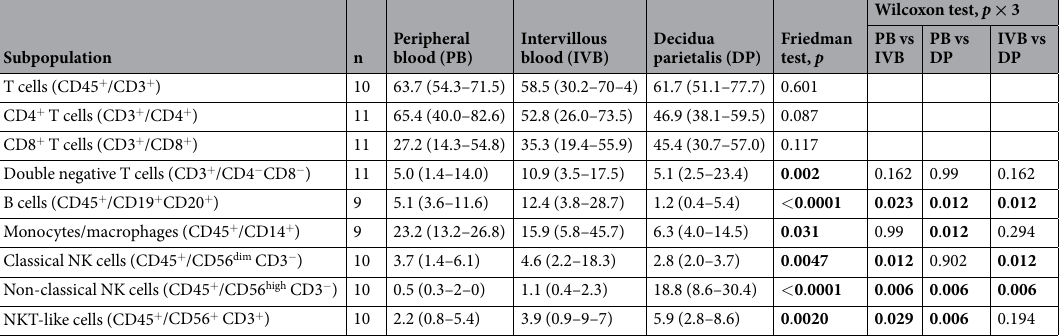
Table 1. Composition of immune cell subsets in peripheral blood, intervillous blood, and decidua parietalis. Subpopulation name, extracellular markers used for identification by flow cytometry and number of paired samples (n). Median values with range of observed values in